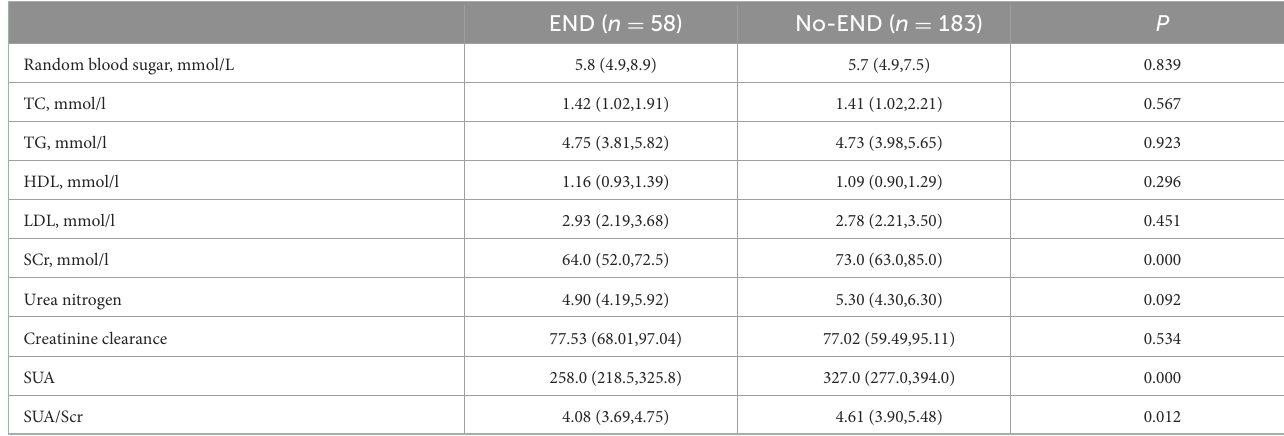
TABLE 2 Laboratory results in both outcome